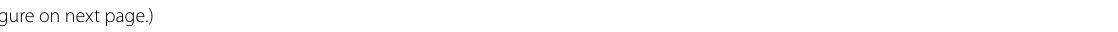
Fig. 2 Effect of stimulating RA FLS imitating the inflammatory microenvironment in joint cavity of RA patients. a The mRNA level of PLCL1 in RA FLS was analyzed by RT‑QPCR after being stimulated by IL‑17A, IFN‑γ, CXCL8, TNF‑a, IL‑1β, IL‑6 and LPS respectively. b The protein level of PLCL1 in RA FLS was analyzed by WB after being stimulated by 0, 2.5, 5, 10 and 20 ng/ml TNF‑α. c The mRNA level of IL‑6, CXCL8 and IL‑1β in RA FLS was analyzed by RT‑QPCR after being stimulated by 0, 2.5, 5, 10 and 20 ng/ml TNF‑α. d The mRNA level of MMP‑3 and MMP‑9 was analyzed by RT‑QPCR in RA FLS after being stimulated by 0, 2.5, 5, 10 and 20 ng/ml TNF‑α. e The expression of PLCL1 and Vimentin were analyzed by double immunofuorescence staining analysis in RA FLS before and after being stimulated by 10 ng/ml TNF‑α. (Compared with the RA group # P < 0.05, ## P